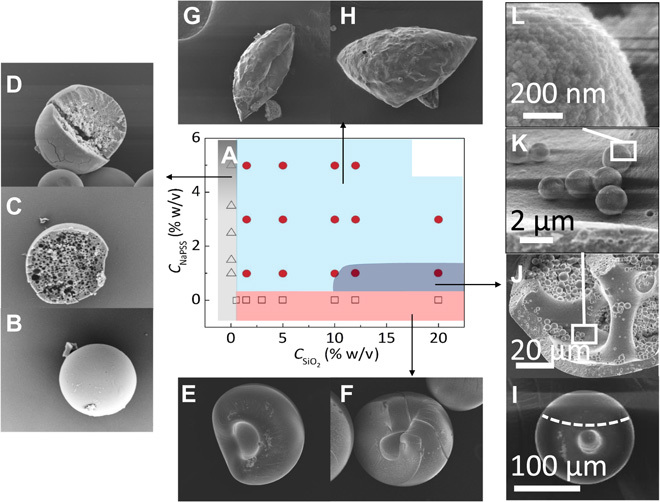
Morphology diagram.Phase map and accompanying SEM images of shape and internal structure of polymer-silica composite capsules as a function of NaPSS and SiO2 content for a fixed initial droplet size (R = 150 μm). Spherical polymer capsules with increasing size and smaller pore dimensions are obtained with increasing NaPSS concentration (Δ), shown in the gray region. Compact and dimpled capsules are obtained in the absence of polymer, with increasing size with silica content (□), shown in the pink region. At most NaPSS/SiO2 compositions, nonspherical capsules with folded geometries (analogous to pollen grains and tricorns) are found, shown in the light blue region. Within a narrow composition range, indicated in dark blue, dimpled capsules with a bicontinuous internal structure are obtained, comprising hierarchical silica microparticles and a composite polymer-nanoparticle shell and scaffold.